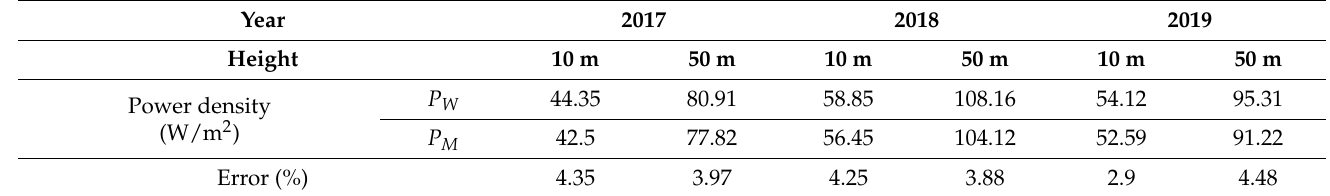
Table 12. The average error between the annual wind power densities calculated using measured data and those estimated by Weibull distribution function.